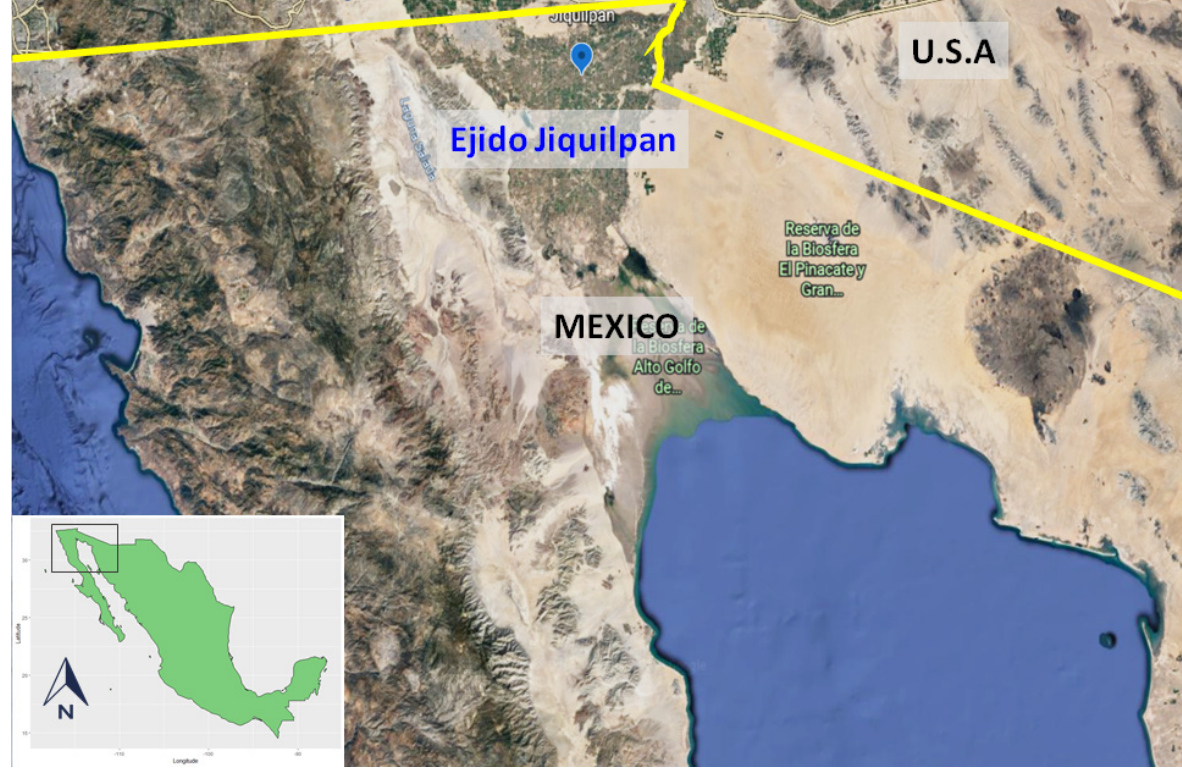
Figure 1. Geographical location of Ejido Jiquilpan, in Northwestern Mexico, where pollen production was characterized.